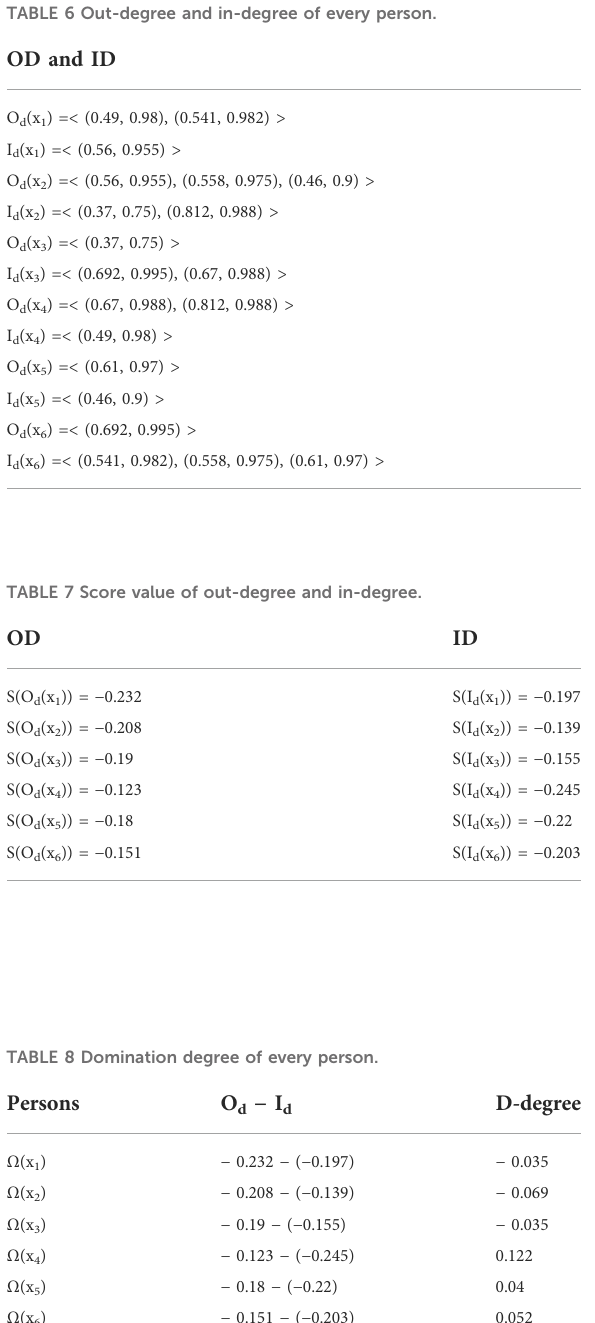
TABLE 6 Out-degree and in-degree of every person.